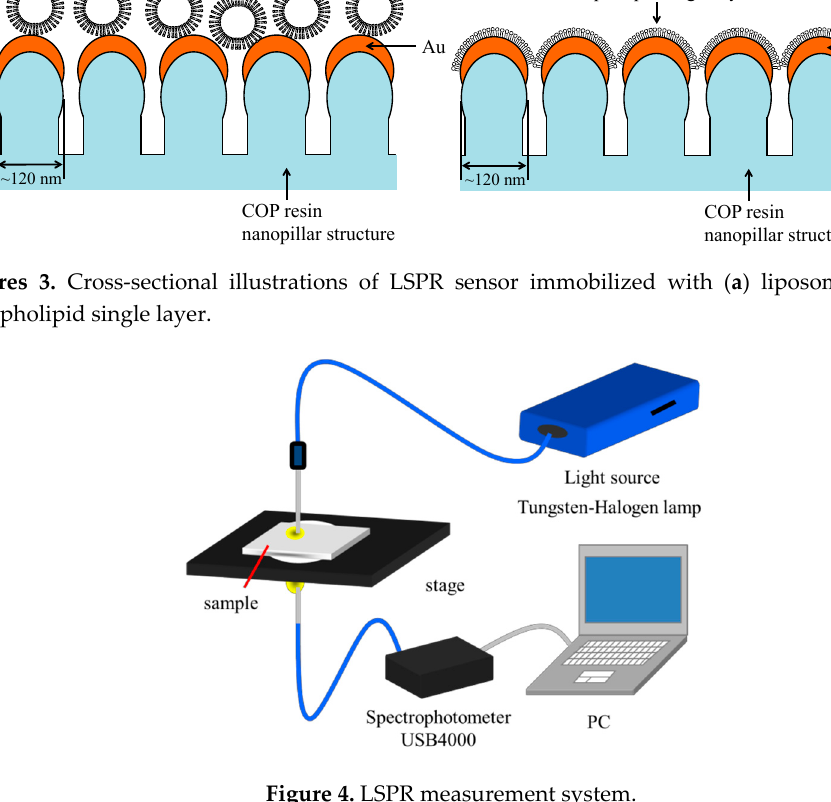
Figure 4. LSPR measurement system.